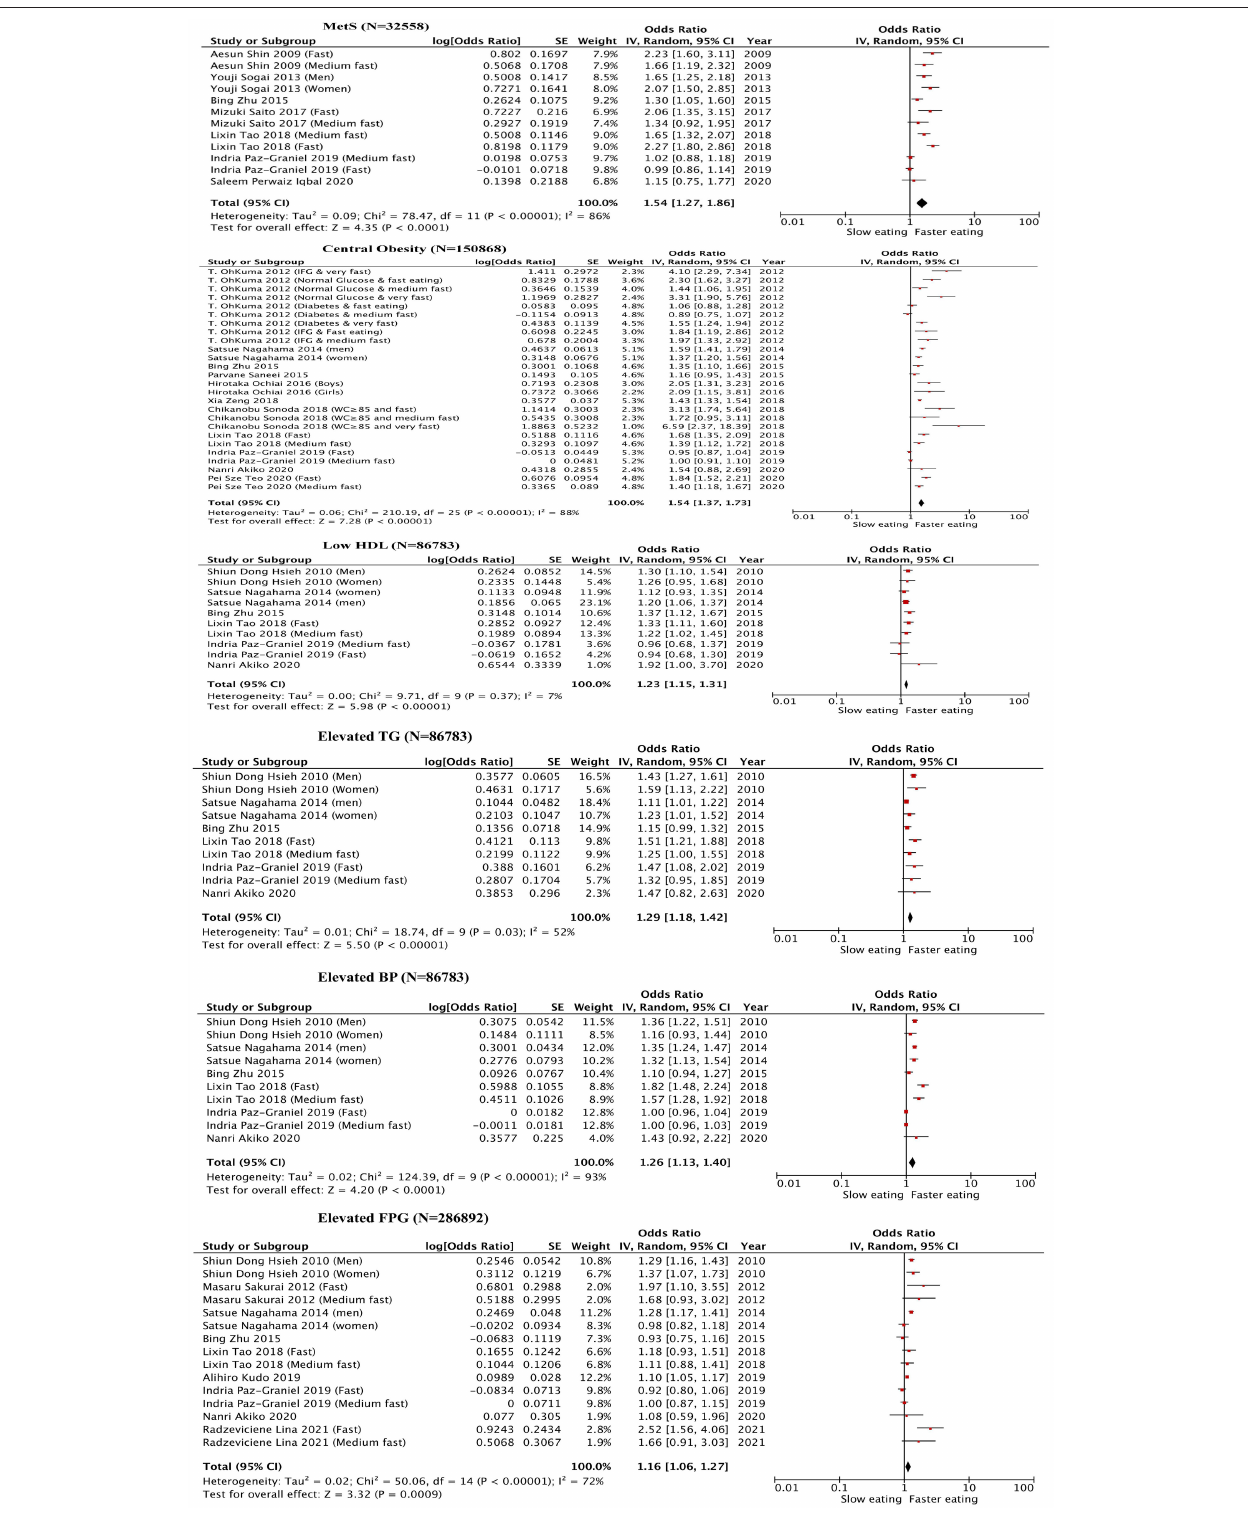
FIGURE 2 | Forest plot of the odds ratios for metabolic syndrome and its components in association with eating rate (The slow eating group were used as the reference group. MetS, metabolic syndrome; BP, blood pressure; FPG, fasting plasma glucose; TG, triglycerides; HDL, high-density lipoprotein).